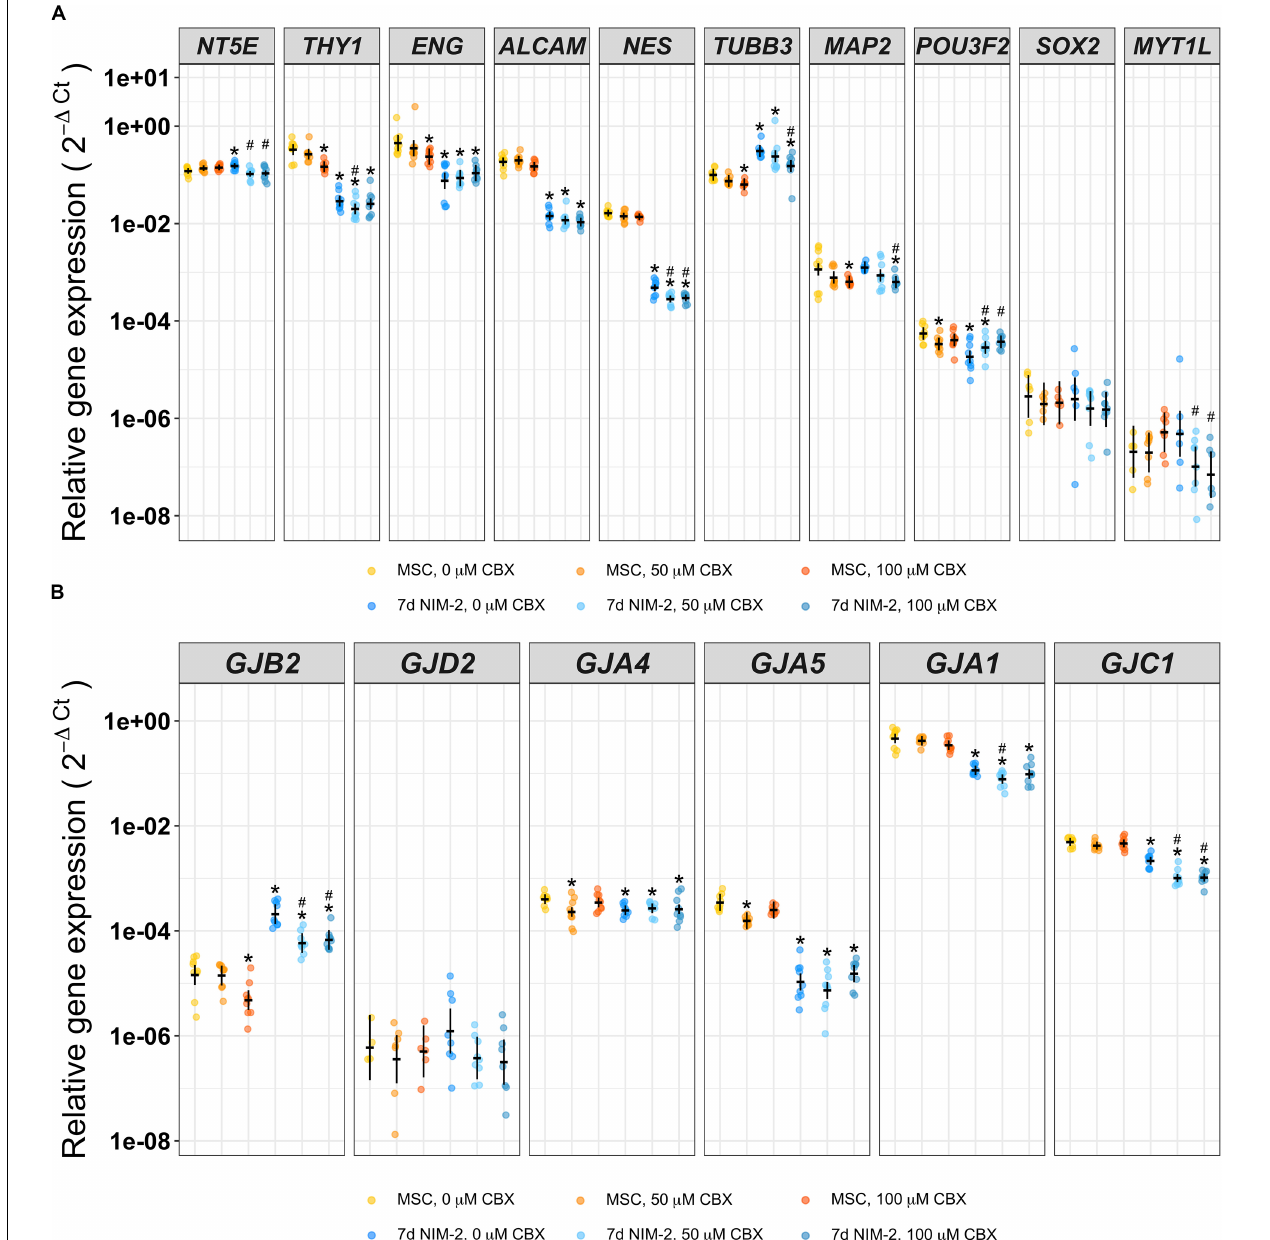
FIGURE 4 | Differentiation of MSCs in presence of the gap junction inhibitor CBX. mRNA of MSCs supplemented with 0 µ M, 50 µ M or 100 µ M CBX for 7 days and of 7 d NIM-2-treated MSCs supplemented with identical concentrations of CBX was analyzed by qRT-PCR. The original data points are plotted in colorful dots. The horizontal lines indicate model-based least-square means together with their 95%-confidence intervals (vertical lines). The * marks significant mean differences ( α = 0.05) between MSC 0 µ M and the other treatments while the # marks significant mean differences ( α = 0.05) of 7 d NIM-2 in presence of 50 µ M CBX and 7 d NIM-2 in presence of 100 µ M CBX compared to 7 d NIM-2 in presence of 20 µ M CBX. (A) qRT-PCR analysis of MSC and neuronal markers. (B) qRT-PCR analysis of GJB2, GJA4 , GJA5 , GJA1 , GJC1 and GJD2